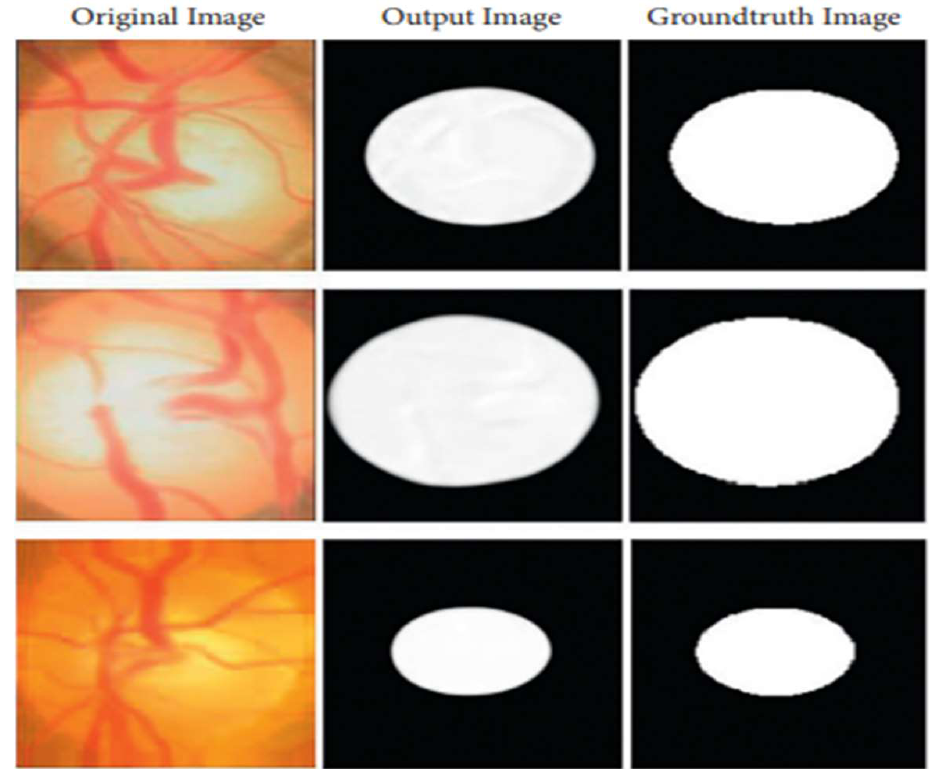
Figure 5. An image created by U-Net that is compared to the actual ground-truth Column 1 shows original images, Column 2 shows output images generated by the proposed method, and Column 3 shows ground-truth images.